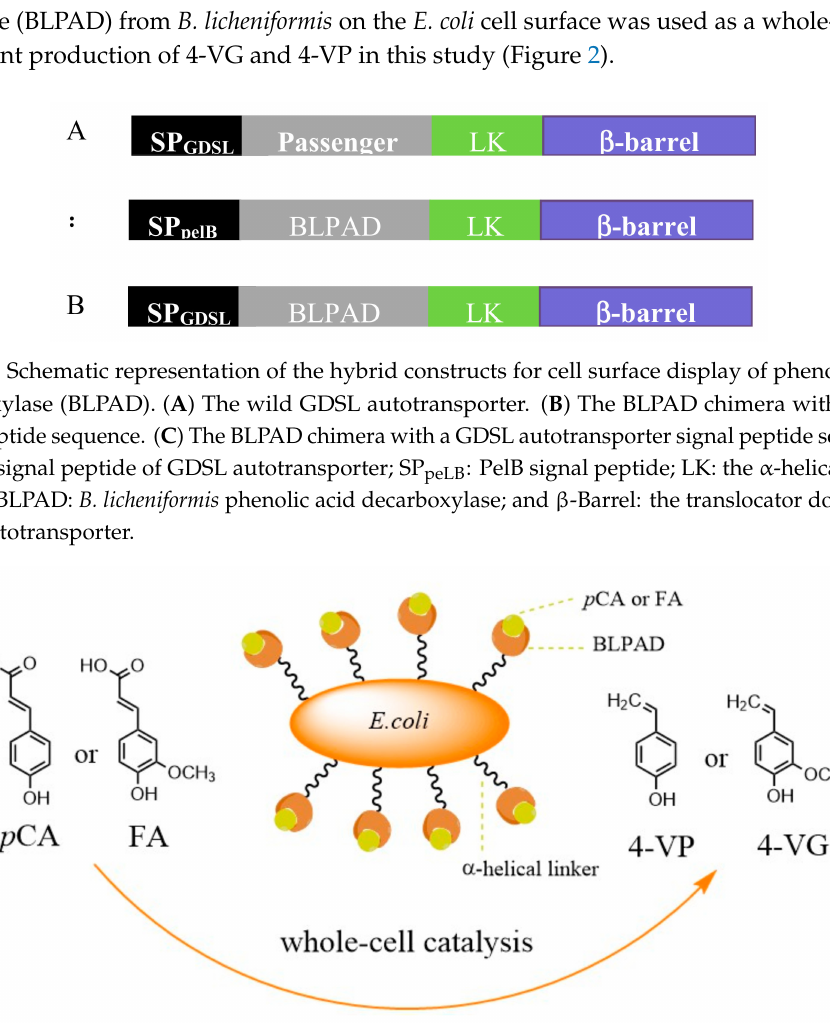
Figure 2. Schematic diagram of the protein surface displayed on the cell and the catalysis of 4-hydroxycinnamic acid to vinyl phenol